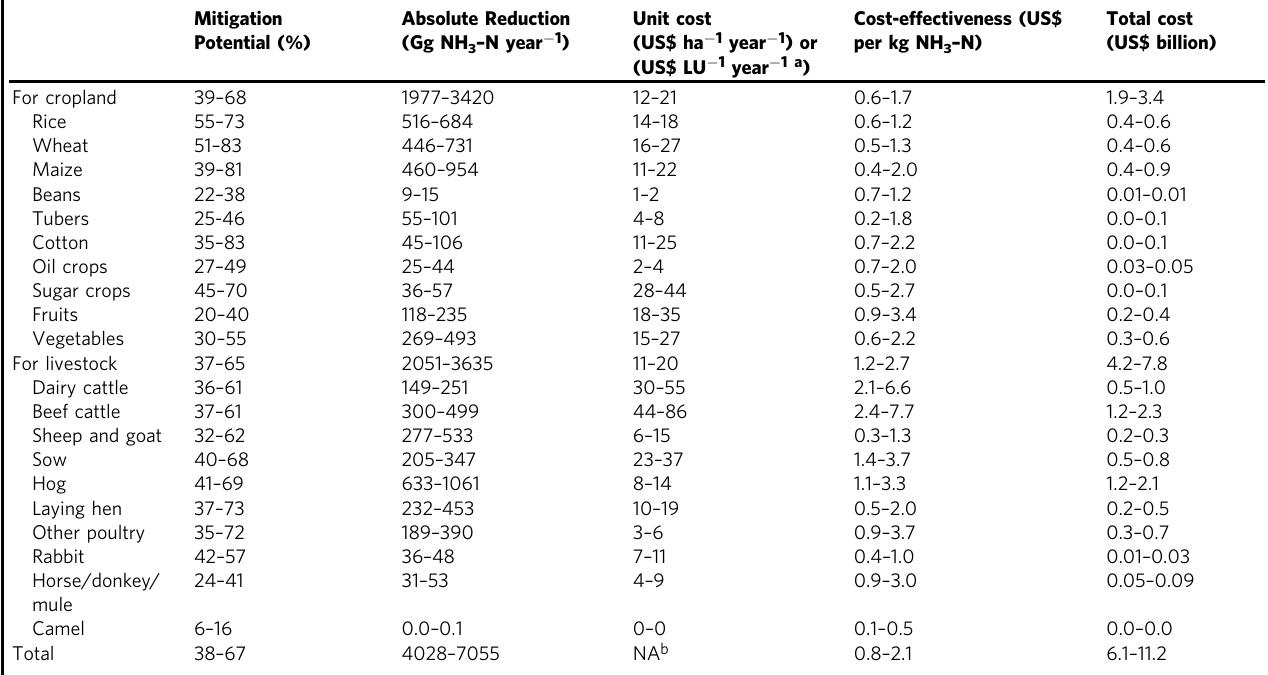
a LUconversioncoef fi cientsusedinthisstudyarederivedfromBaietal. 27 ,namely,1headofdairycattle,beefcattle,pig,sheepandgoat,layer,andbroilerequal1.0,0.50,0.35,0.10,0.012and0.007LU, respectively b NA means data “ Not Available ” or “ Not Applicable.